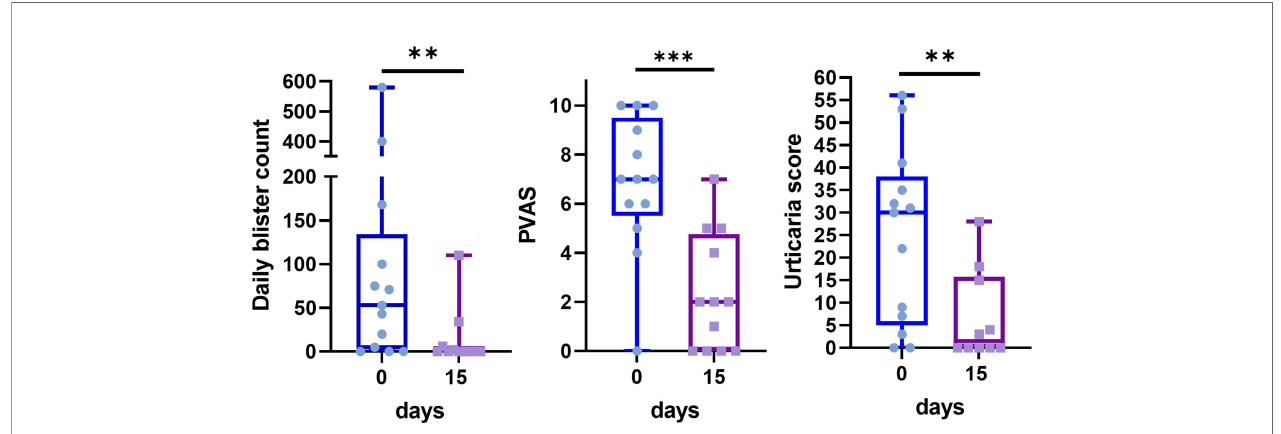
FIGURE 2 | Dramatic improvement of daily blister count, pruritus visual analog score (PVAS) and urticaria score between baseline (blue) and the 15 th day after omalizumab therapy (purple). Data are presented as box and whisker plots showing extreme values, interquartile ranges, and medians. ** p < 0.01, *** p < 0.001 (Wilcoxon signed – rank test).